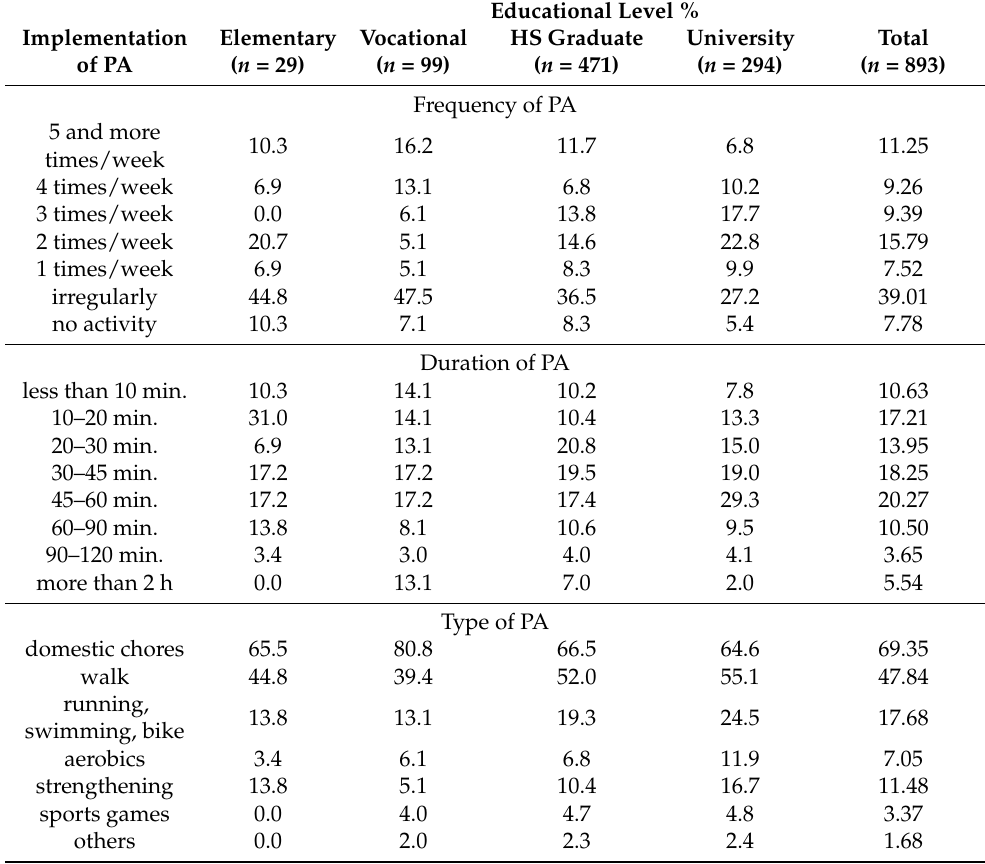
Table 5. Frequency, duration, and type of PA performed in relation to education of NCD